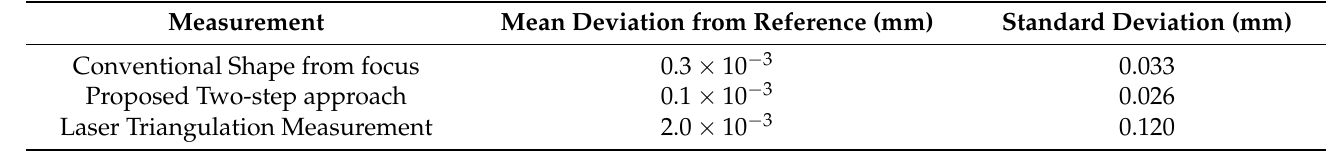
Table 2. Measurement result of comparison with reference, measured with keyence